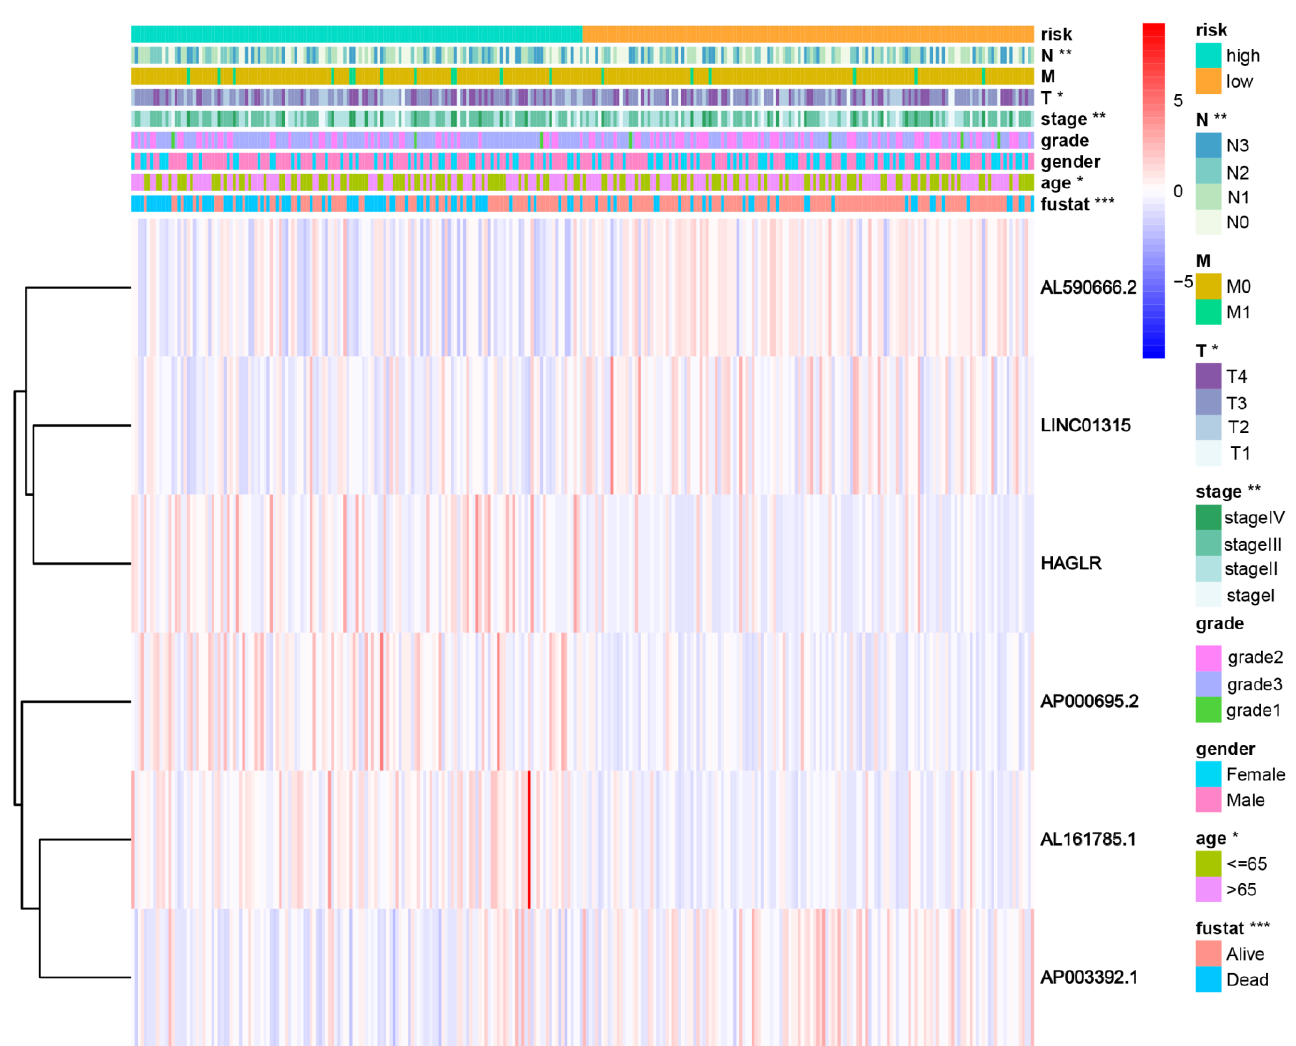
Figure 5. The connection with the prognostic PRlncRNAs, as well as the clinicopathological factors with the risk groups. * p < 0.05; ** p < 0.01; and *** p < 0.001. Fustat: vital status.